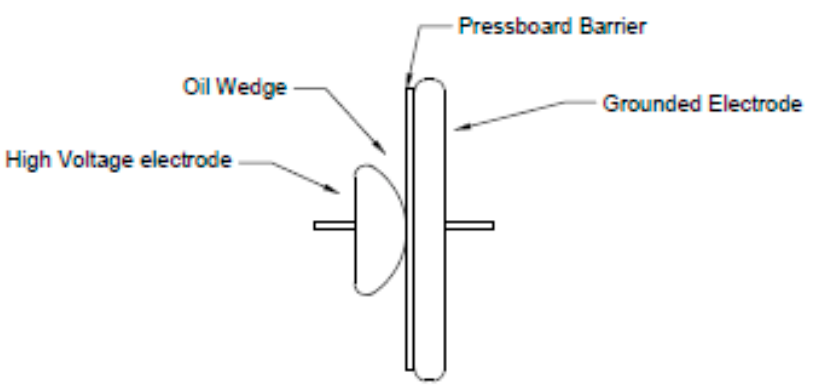
Figure 2. The model electrode system for the oil wedge considered in this study.